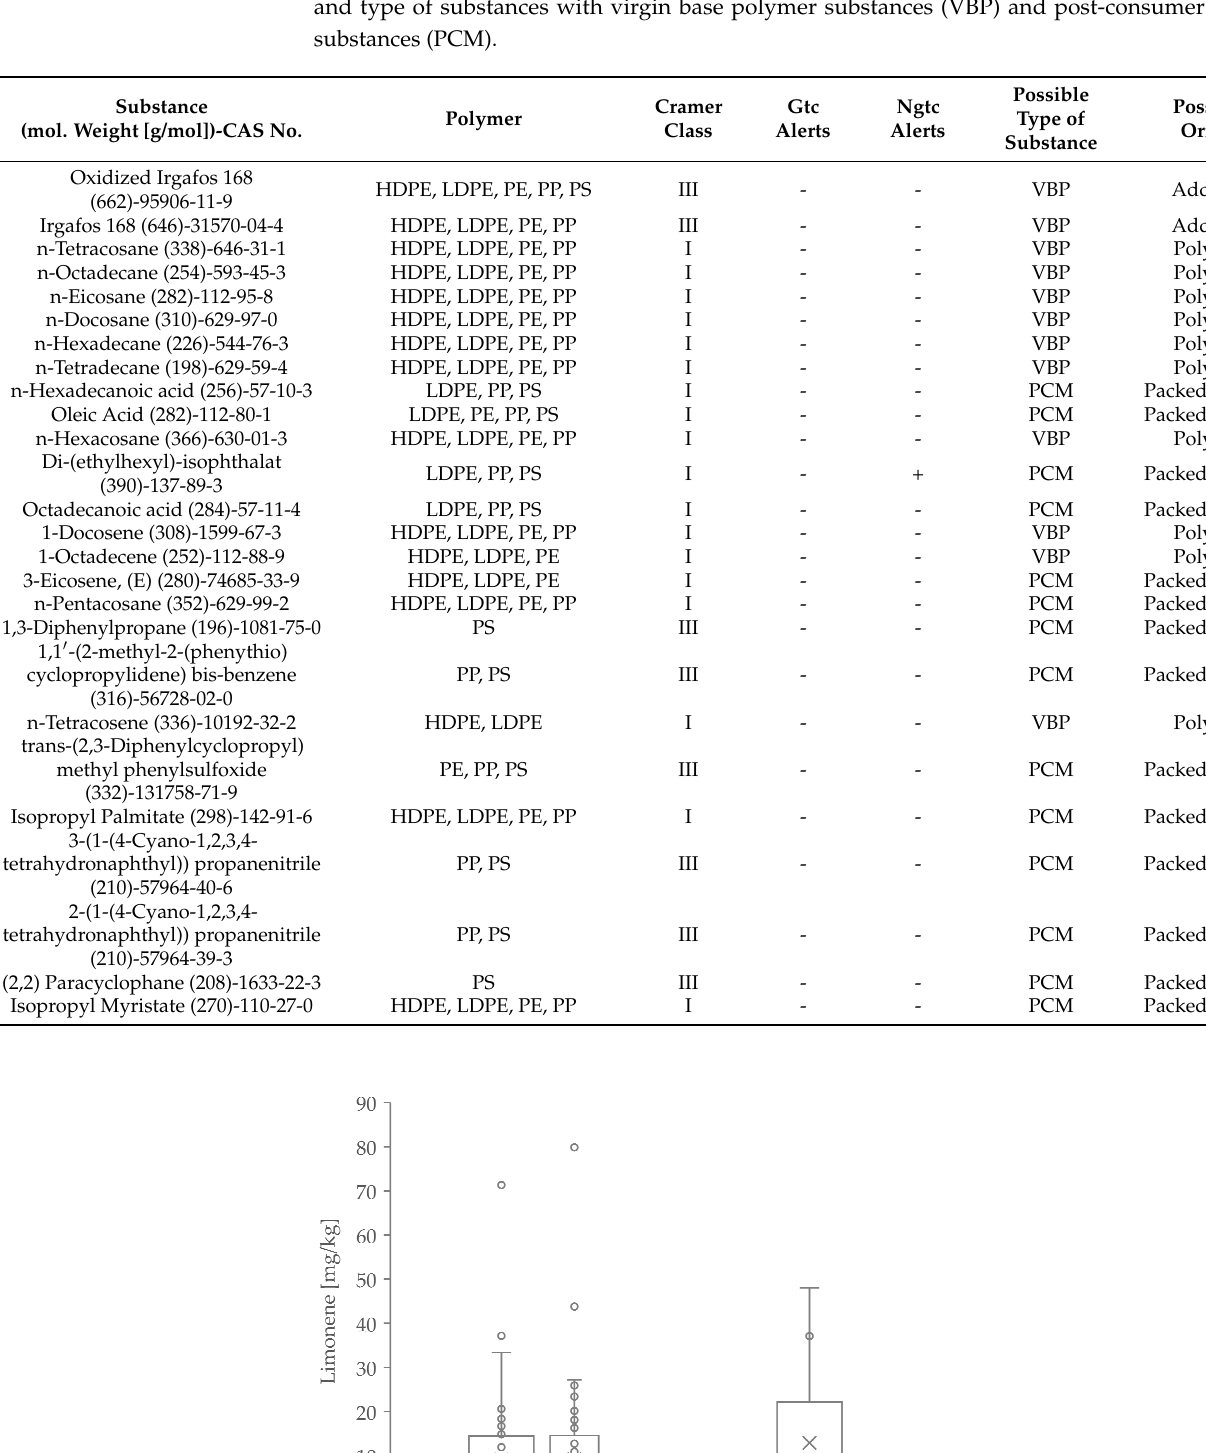
Figure 4. Boxplot analysis of limonene concentrations in the analyzed polymers. (× = Mean, ° = Outlier).